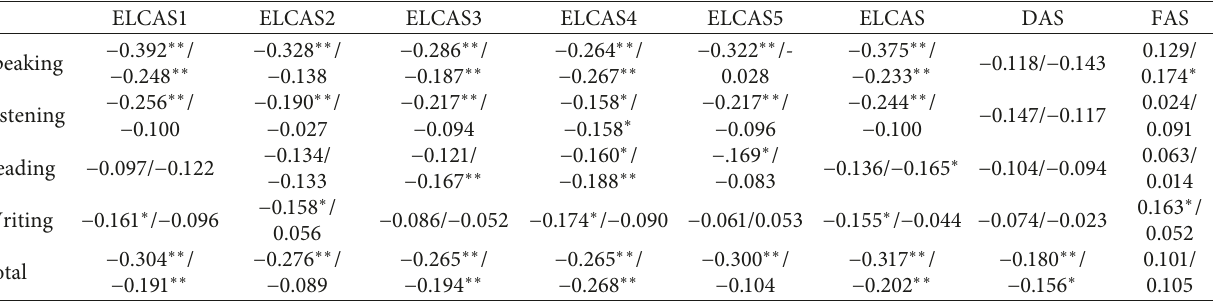
Table 7: Correlations between ELCAS and AAT scales ( N � 324).